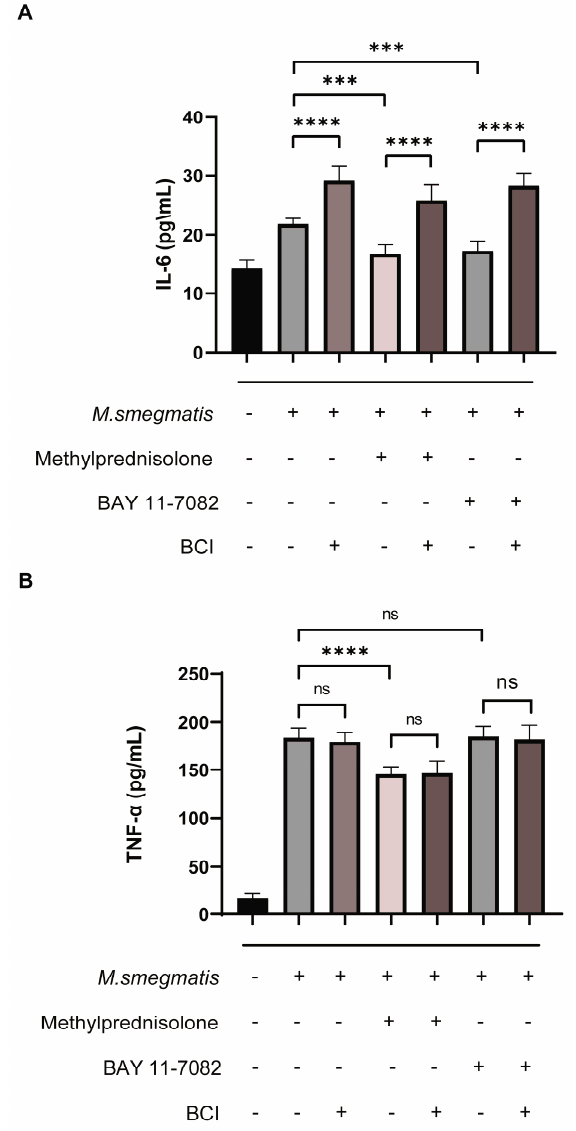
Figure 9. RAW264.7 cells infected with M. smegmatis were treated with methylprednisolone (10 2 µ M), BAY 11-7082 (2 µ M), and BCI (1 µ M) for 48 h, and the cell supernatant was collected for enzyme linked immunosorbent assay. ( A ) IL-6 secretion level, ( B ) TNF- α secretion level. The analysis of variance was used for data analysis, *** p < 0.001, **** p < 0.0001, ns no statistical differences.